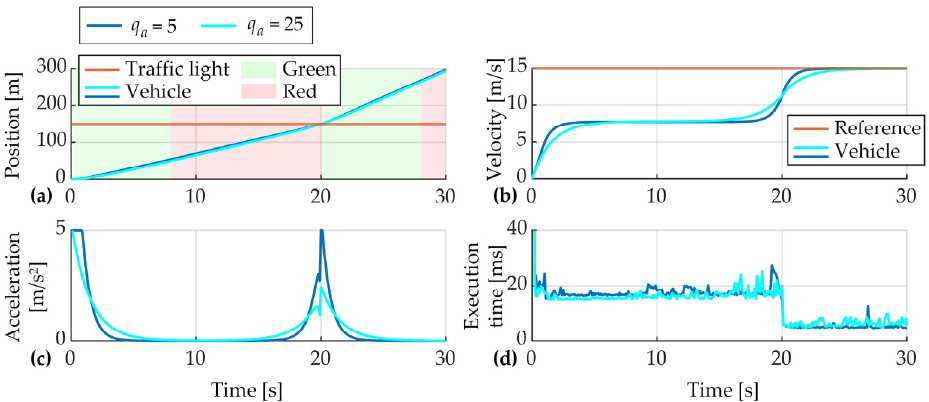
Figure 10. Illustration of influence of acceleration weighting coefficient q a on position ( a ), velocity ( b ), acceleration ( c ) and execution time ( d ).